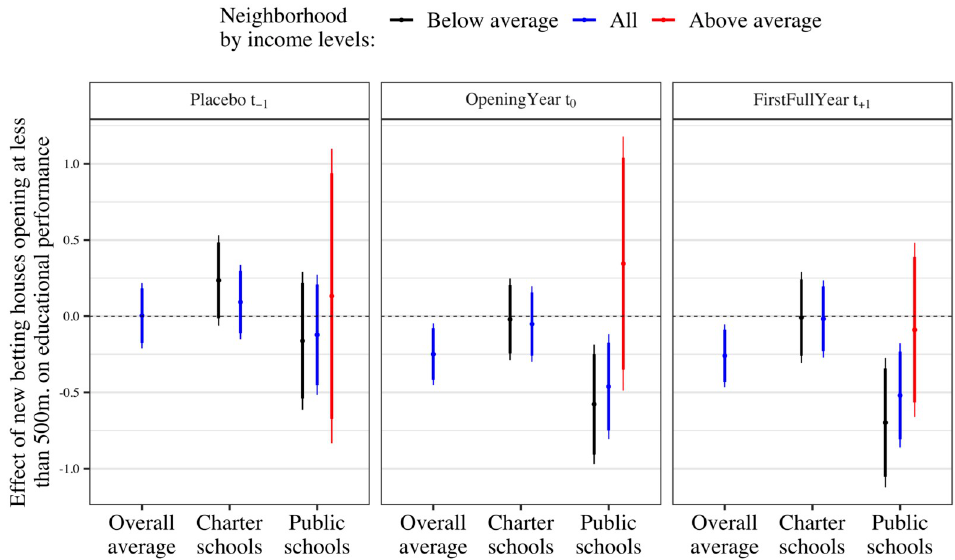
Fig 2. Main result. The estimated effect of exposure to betting houses on educational performance using TWFE estimators. Note: The figure shows the point estimates and robust 95% (thin) and 90% (thick) confidence intervals estimated using Eq 1. All models include school-level and year-fixed effects. The outcome variable is the school-level average grade obtained by all the students that sit the state-level exam (mean, 6.26; SD, 0.7). The overall sample contains 235 high schools, 149 charter, and 86 public. Models on the effect of betting houses on charter schools in neighborhoods below income average use 75 high schools, and those in neighborhoods above the average income 75 schools. Models focusing on the effect on public high schools include 62 high schools (242 observations) when analyzing below-average- income areas and 25 schools (100 observations) when approaching the effect of gambling facilities on public high schools located in high-income neighborhoods of